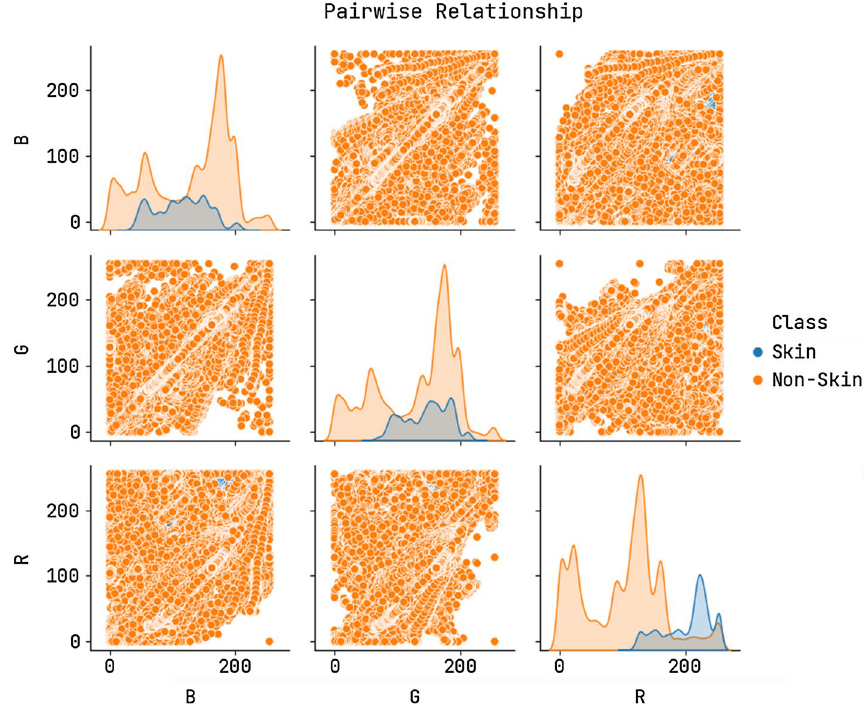
Fig. 6 Pairwise relationship of class labels in skin